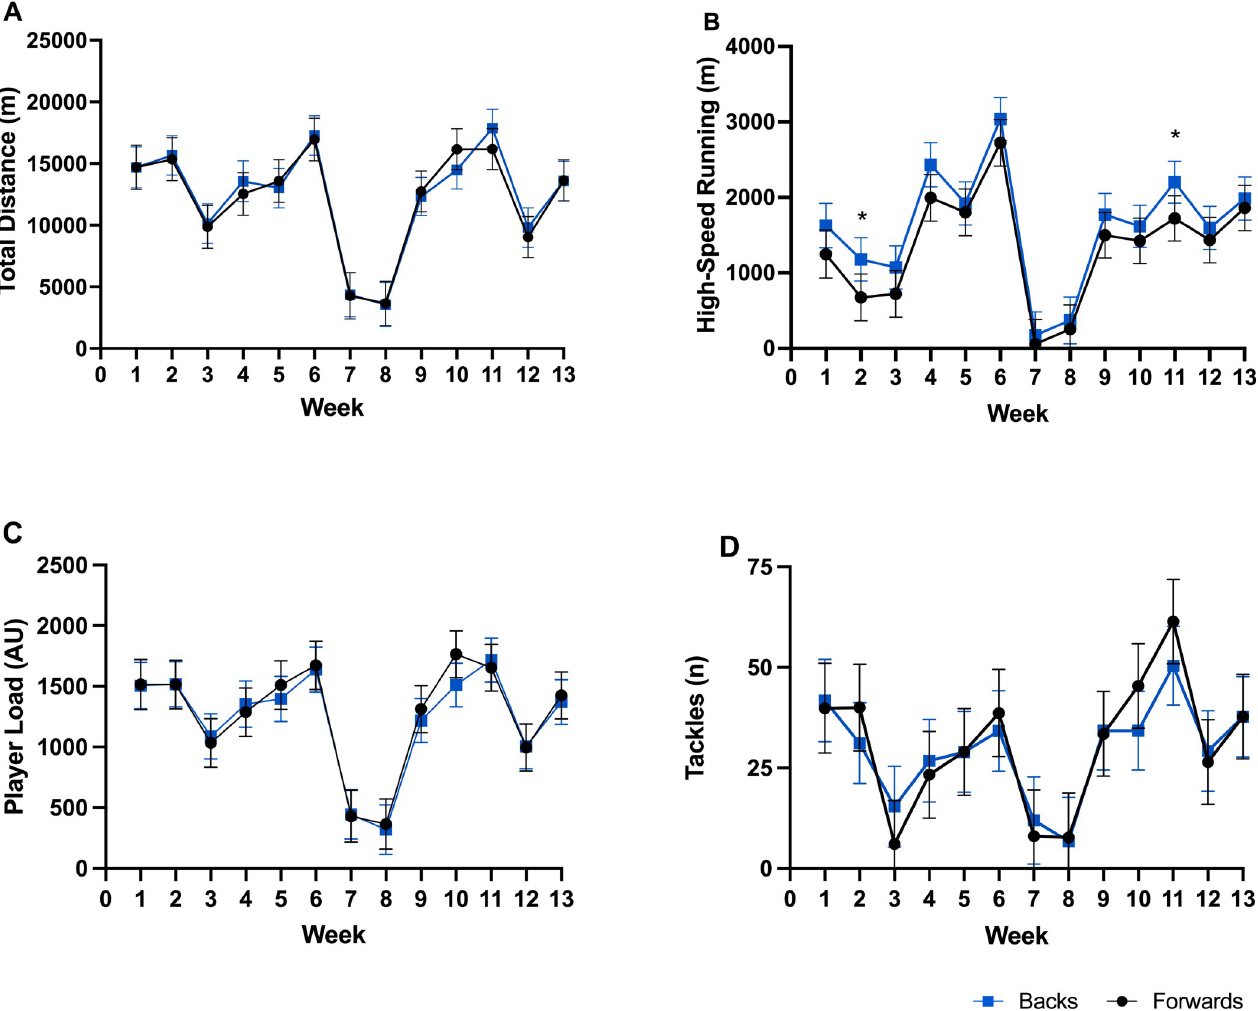
Fig 1. Total weekly field-based external load, between positional groups, across weeks. (A) Total distance, (B) High-speed running, (C) PlayerLoad, (D) Tackles. � Difference between forward and back playing positions (p < 0.05).